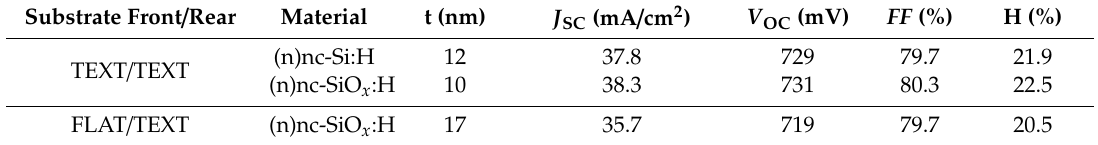
Table 1. J-V parameters of best solar cells fabricated on both-sides-textured and 1-side-textured c-Si wafers with (n) doped nc-Si:H and nc-SiO x :H placed on the front side. Data from [28,73]. Substrate Front /